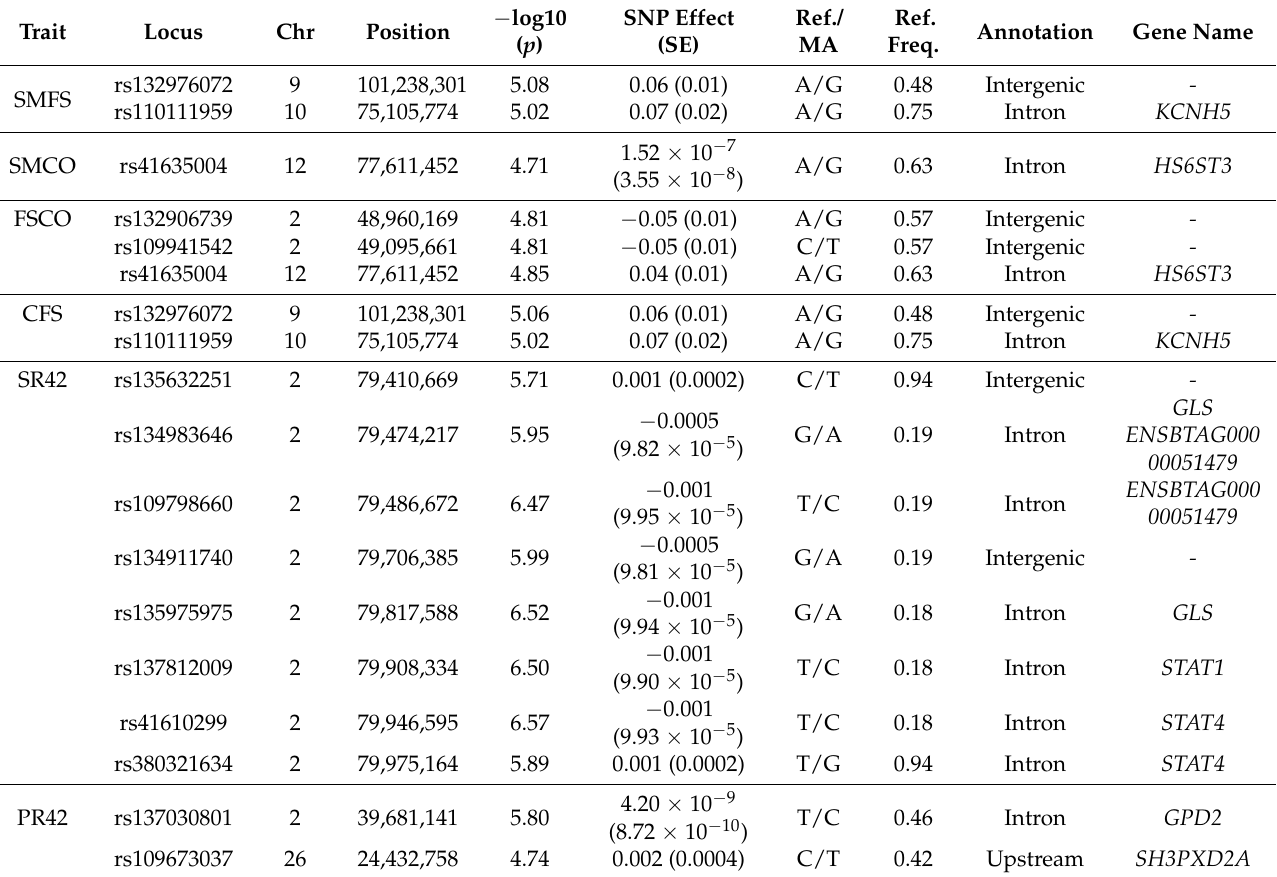
Table 4. The single nucleotide polymorphisms (SNPs) that were identified as significant at genome- wide and suggestive significance thresholds for the fertility